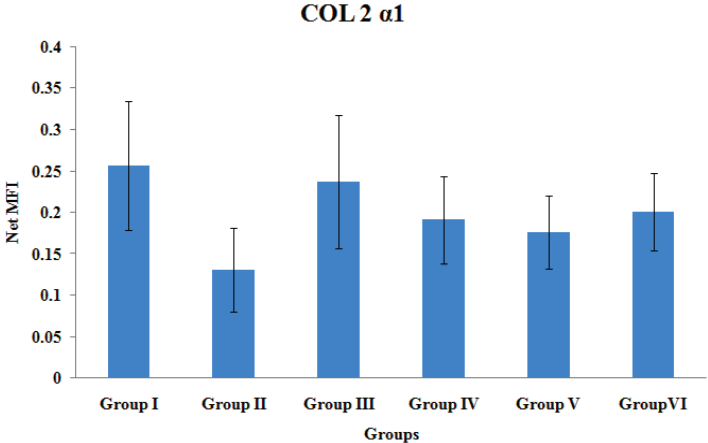
Figure 8. Col 2 α 1 Gene Expression. Samples were normalized to GAPDH MFI (Median Fluorescence Intensity). Values were expressed as mean ± SEM. Group I: sham-operated